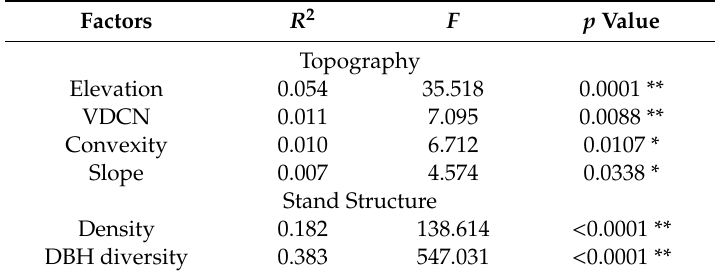
Signi fi cance at * p < 0.05; ** p < 0.01.